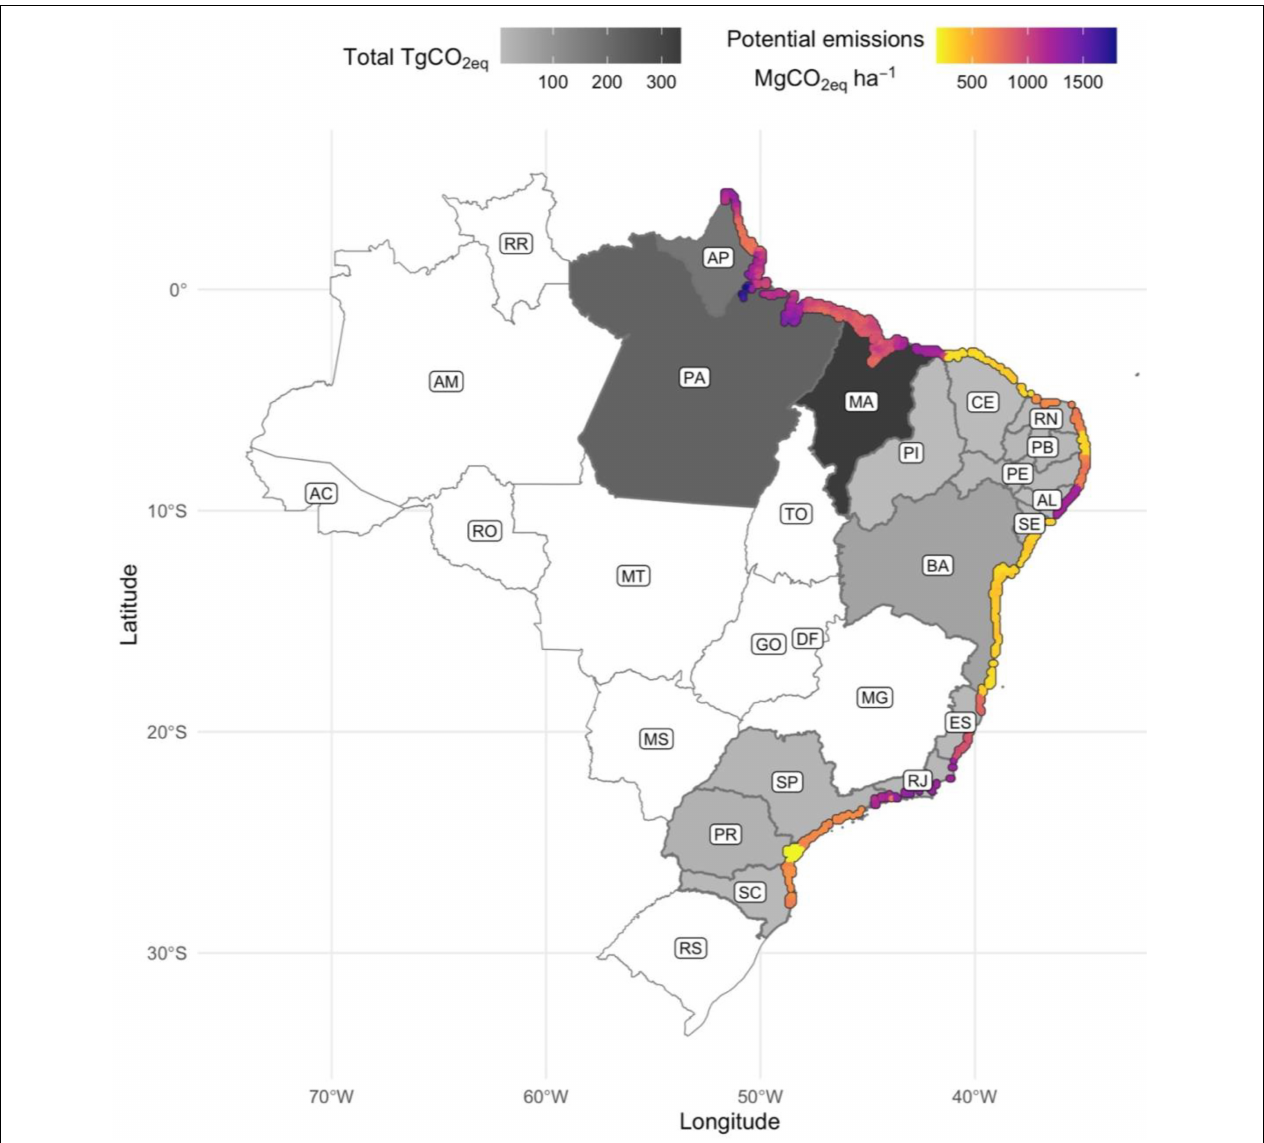
FIGURE 2 | Total CO 2eq stored in biomass and soils (grayscale top left legend) and variability in potential CO 2eq emissions (colored scale top right legend) across Brazilian mangroves. Mangrove coverage exaggerated to improve visualization. Estimates per state are given on Table 5 . Mangrove states: AP, Amapá; PA, Pará; MA, Maranhão; PI, Piauí; CE, Ceará; RN, Rio Grande do Norte; PB, Paraíba; PE, Pernambuco; AL, Alagoas; SE, Sergipe; BA, Bahia; ES, Espírito Santo; RJ, Rio de Janeiro; SP, São Paulo; PR, Paraná; and SC, Santa Catarina. Non-mangrove states: RR, Roraima; AM, Amazonas; AC, Acre; RO, Rondônia; MT, Mato Grosso; TO, Tocantins; GO, Goiás; DF, Distrito Federal; MS, Mato Grosso do Sul; MG, Minas Gerais; RS, Rio Grande do